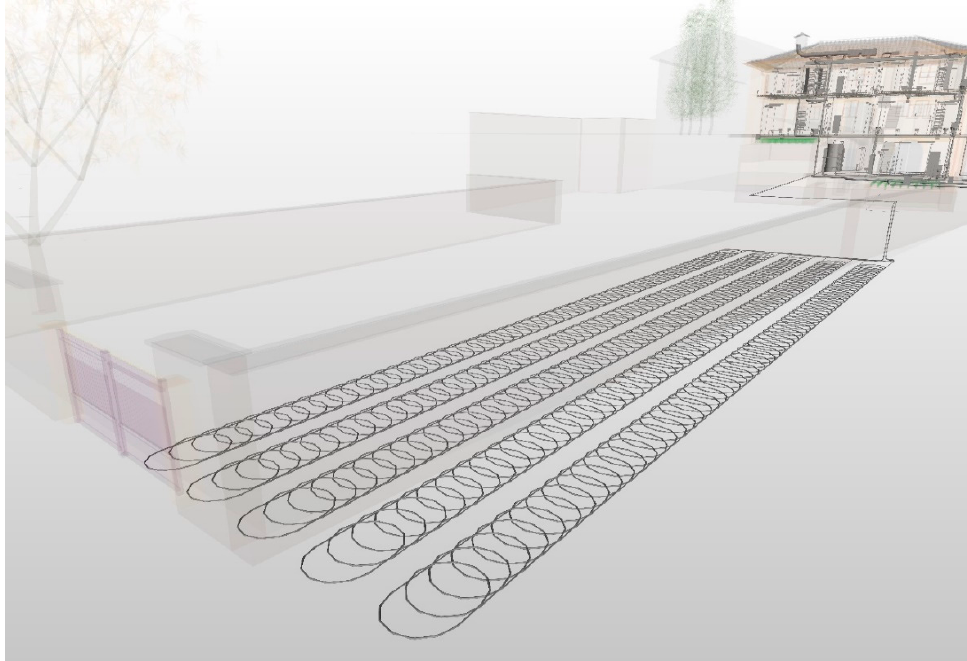
Figure 5. Sandwich configuration of the ground lodging the slinky ground source heat exchangers (GHEXs).